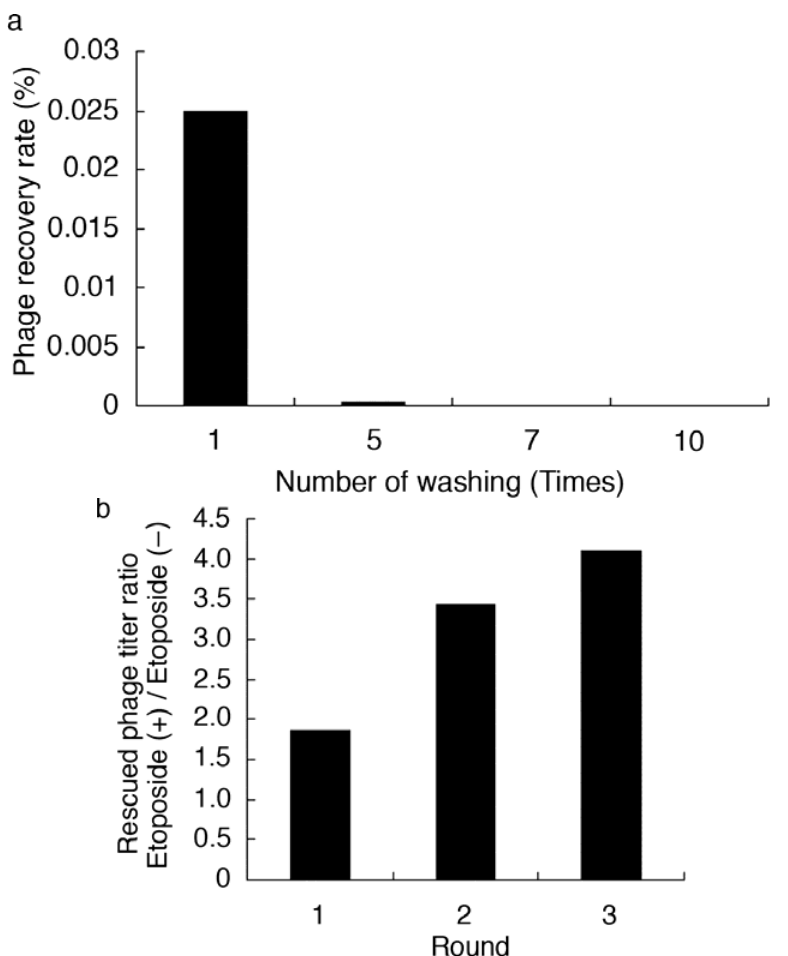
Figure 3. ( a ) Phage recovery rate in wash solution. Recovery rate (%) = titer of the washing fraction / titer of the input (1.0 × 10 8 pfu) × 100. ( b ) Rescued phage titer in each round of selection.